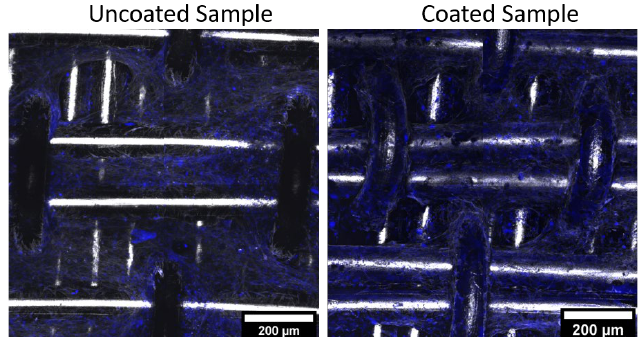
Figure 8. DAPI and phalloidin stains on uncoated and Hap-coated SS woven lattices after 4 days.